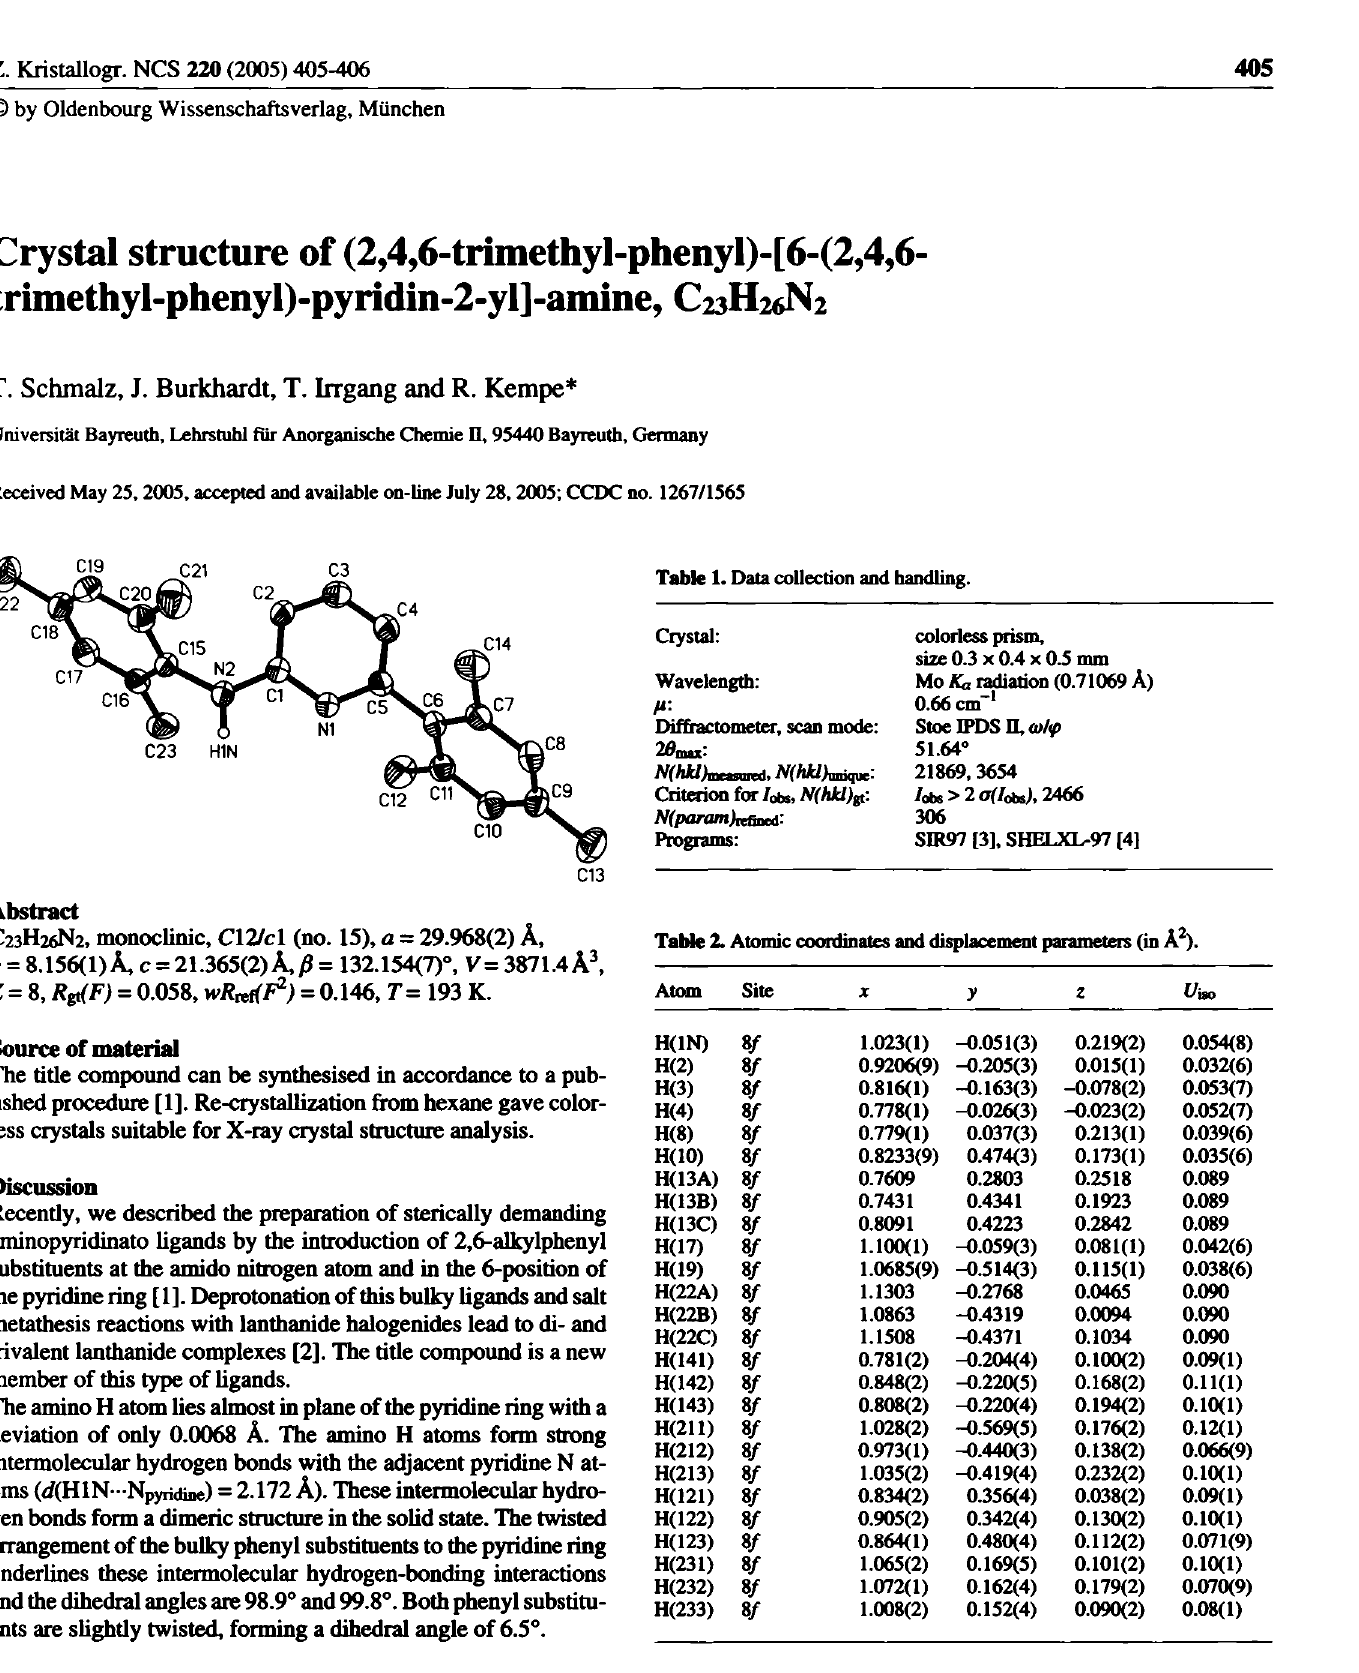
Table 2. Atomic coordinates and displacement parameters (in A 2